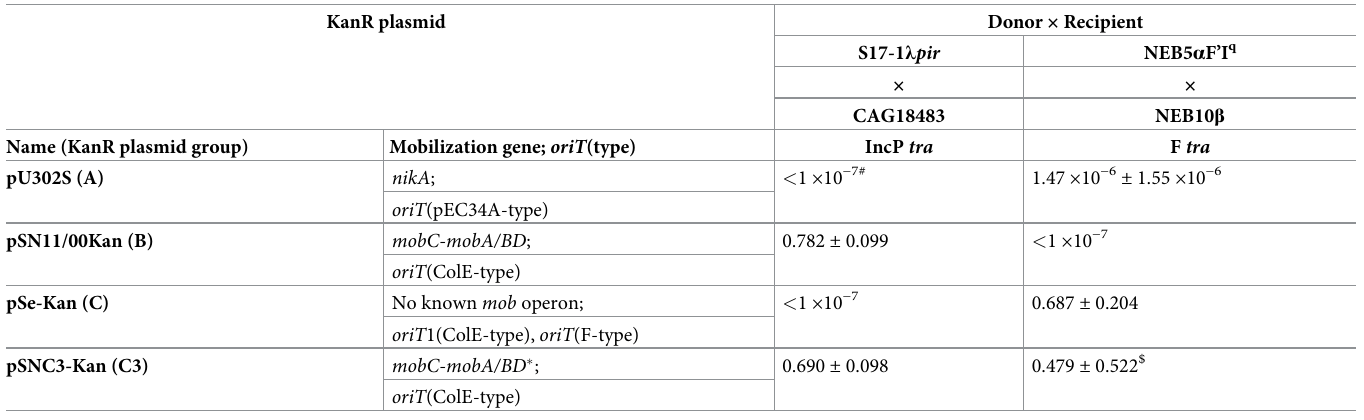
Table 3. Mobilization of KanR plasmids by conjugative transfer genes of IncP and F derivatives. KanR